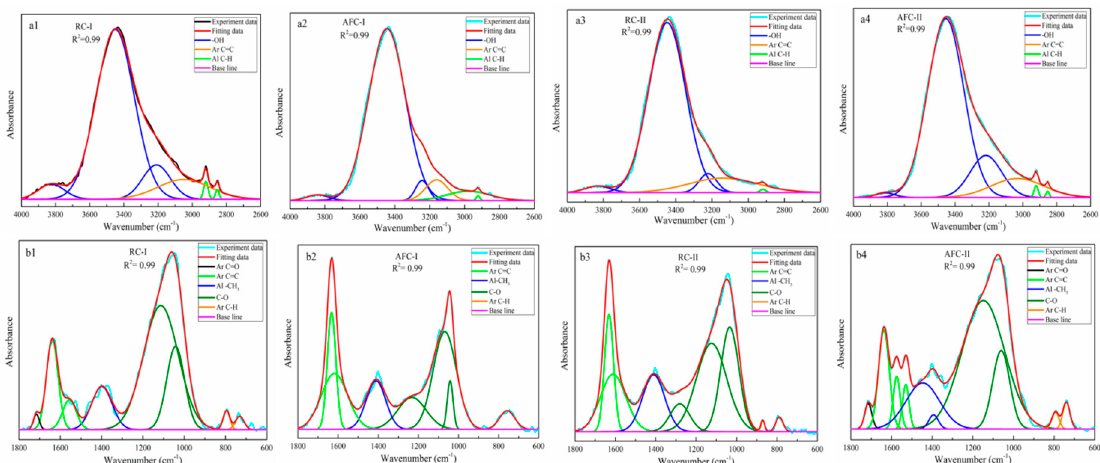
Figure 7. Infrared spectra of selected samples with the corresponding curve fitted bands in the ranges